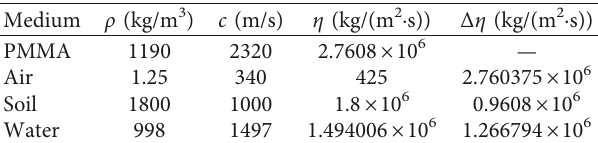
Figure 4: Water-filled PMMA specimens after explosion. Table 2: Four kinds of media wave impedance relationship at room